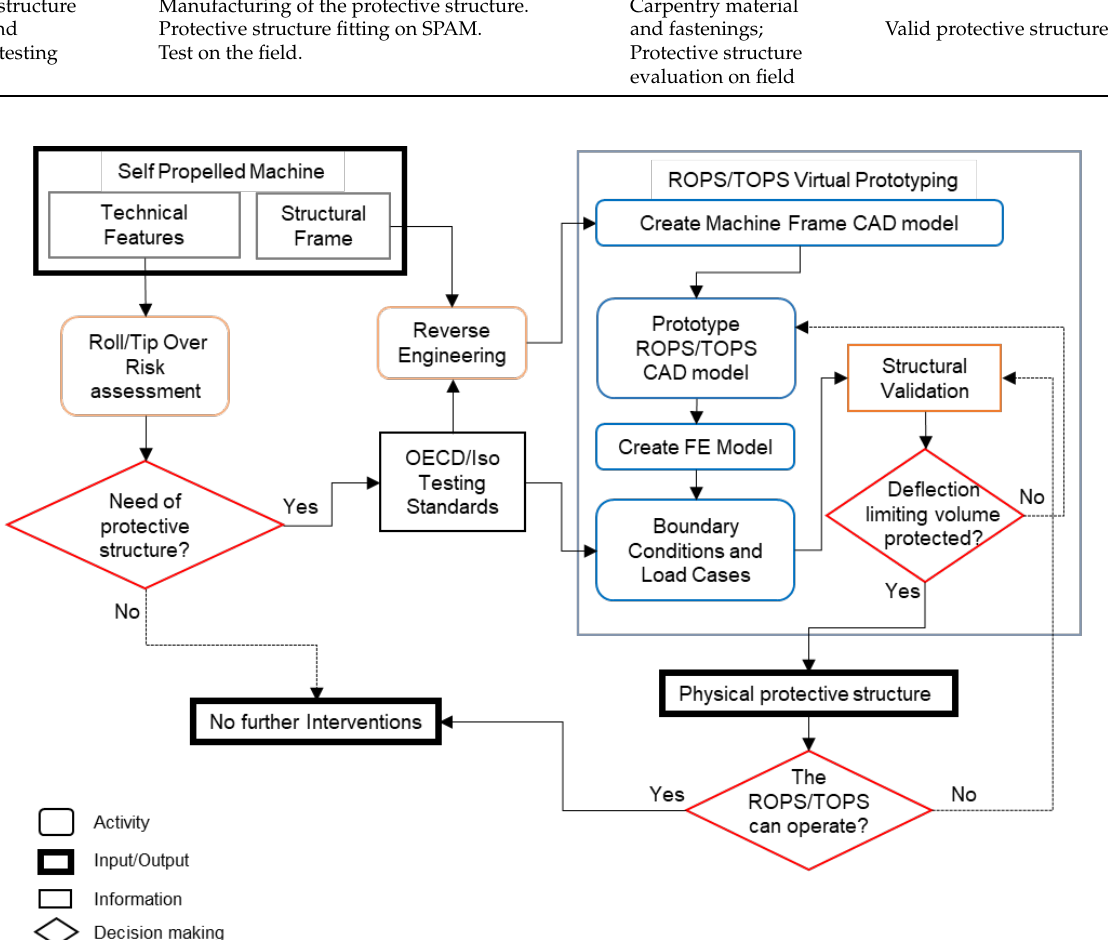
Figure 3. Decision-making flow chart depicting tools and activities involved in the ROPS/TOPS development.